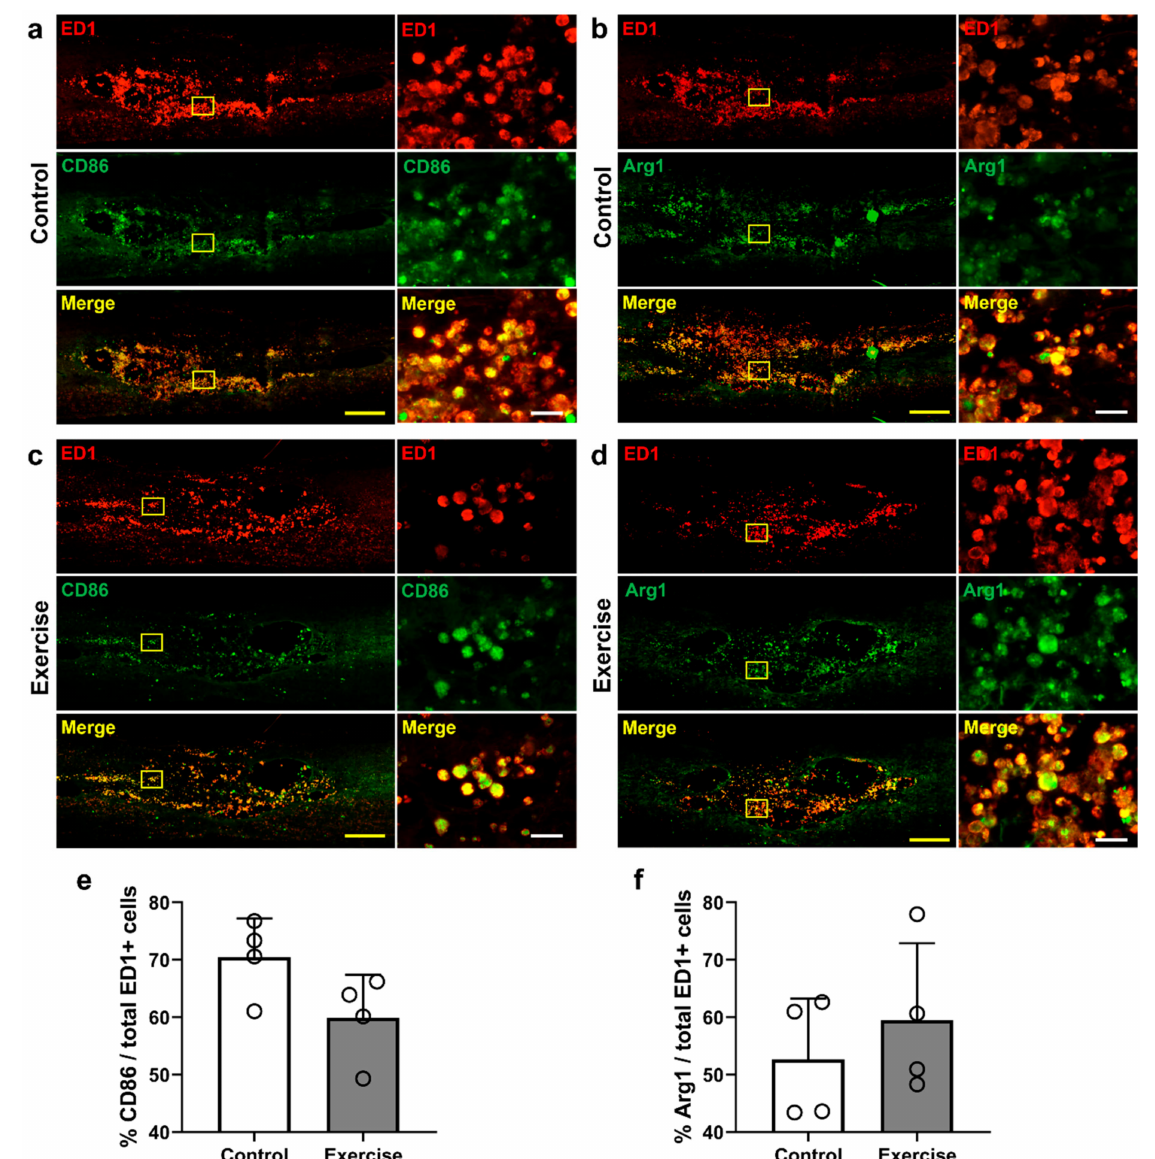
Figure 6. Immunofluorescent findings related to macrophage M1/M2 polarization 12 weeks after injury. ( a ) Representative images of CD68- and ED1-positive M1 macrophages and ( b ) Arg1- and ED1-positive M2 macrophages in the control group and ( c ) CD68- and ED1-positive M1 macrophages and ( d ) Arg1- and ED1-positive M2 macrophages in the exercise group. ( e ) Number of cells positive for ( e ) CD86 and ( f ) Arg1, normalized to ED1-positive cells ( n = 4 per group). p < 0.05 between the control and exercise groups by the Mann–Whitney U test. Yellow scale bar = 500 µ m, white scale bar = 50 µ